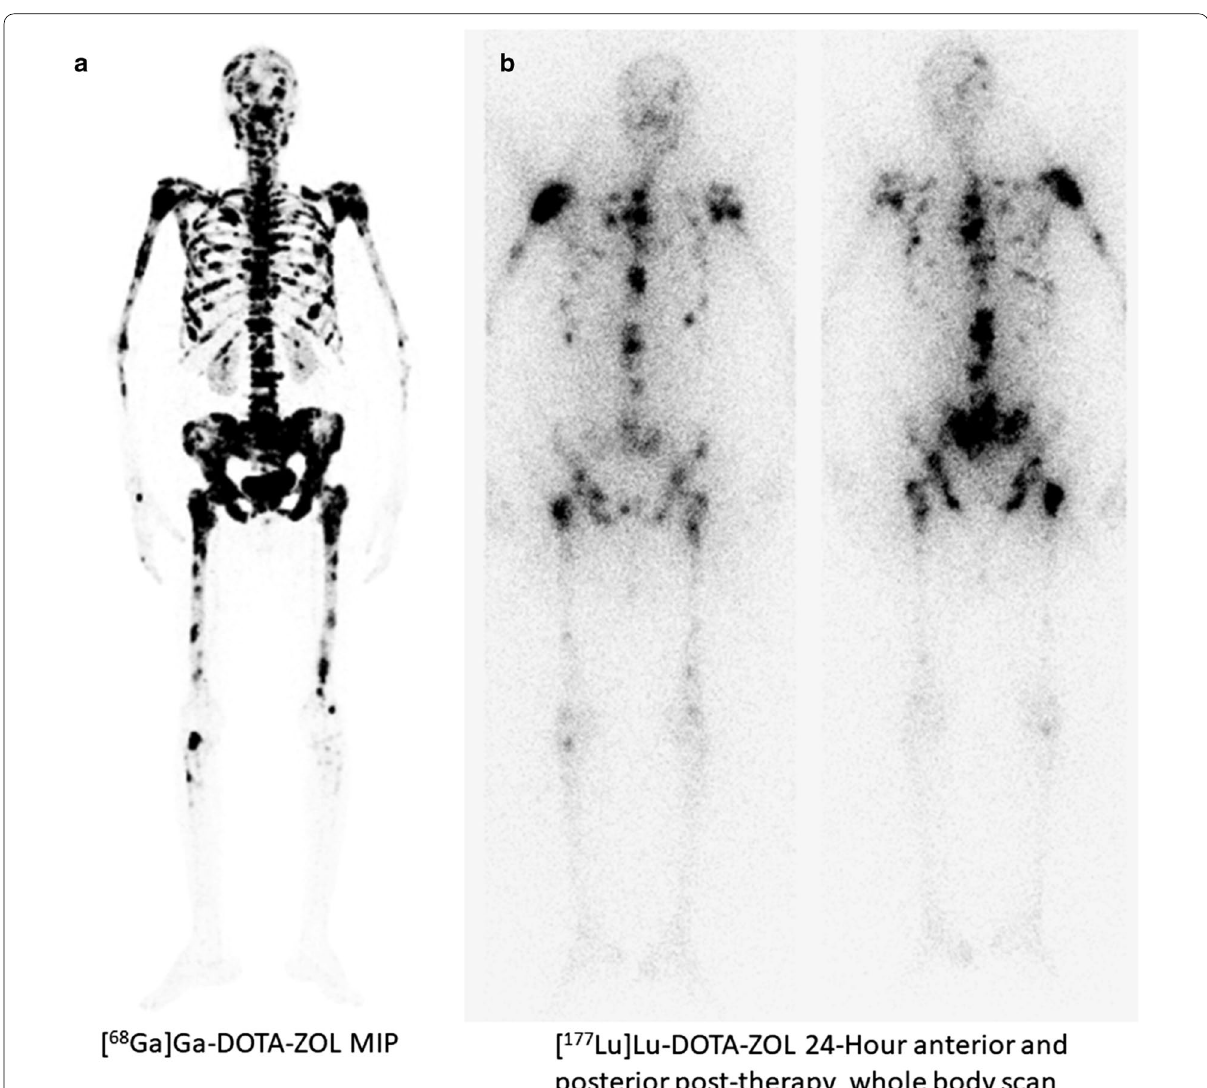
Fig. 2 A 45-year-old female, diagnosed with triple-negative breast cancer was on opioid medications, but did not experience any relief in pain. Her baseline pain scoring (VASmax) was 8/10. Baseline [ 68 Ga]Ga-DOTA-ZOL PET/CT ( a ) was conducted followed by administration of 1.3 GBq of [ 177 Lu]Lu-DOTA-ZOL. Twenty-four-hour post-administration, post-therapy 24-h anterior and posterior whole body scan ( b ) demonstrate avid [ 177 Lu] Lu-DOTA-ZOL uptake in multiple skeletal